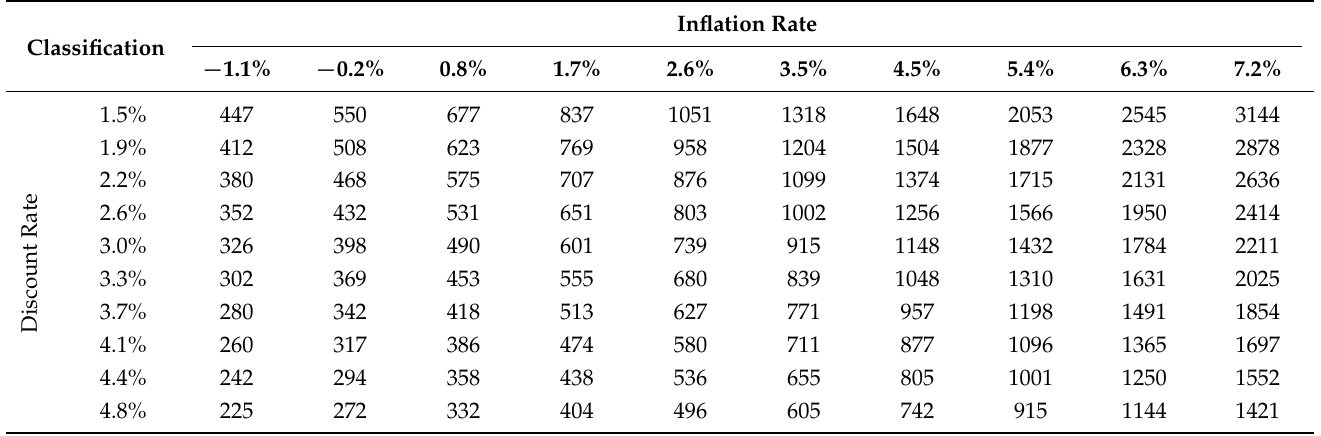
Table A2. The results of our sensitivity analysis of inflation and discount rates: the maximum net present